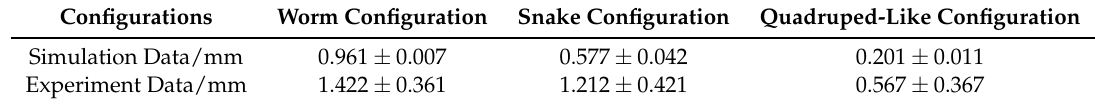
Table 1. Mean and variance values of simulation and experiment data of three robot